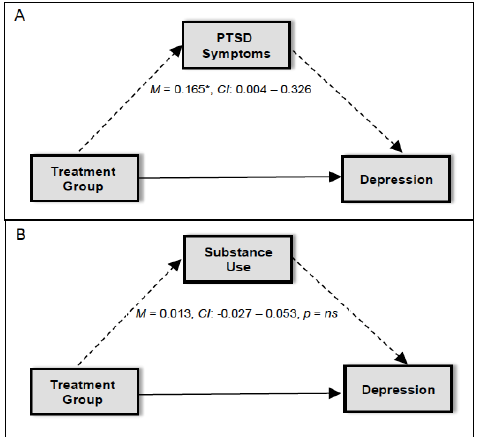
Figure 1. Diagram for the mediation model for ( A ) PTSD symptoms and ( B ) substance use as a mediator in the association between treatment group and depression. * p < 0.05.